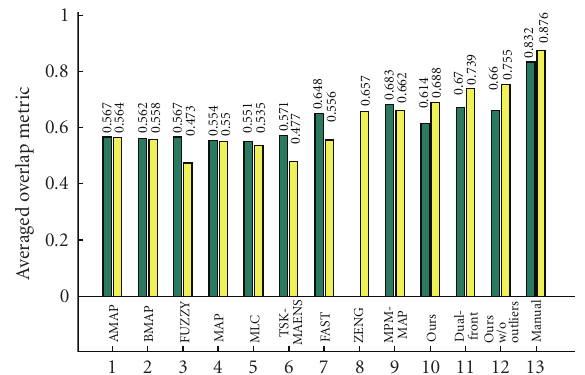
Figure 15: Average OM for WM and GM segmentations on 20 normal real brain data of T 1 -weighted modality. The left and right columns denote the average OM of WM and GM segmentation respectively. Some statistics are from IBSR and others are from [5]. They represent: AMAP: adpaptive MAP, BMAP: biased MAP,